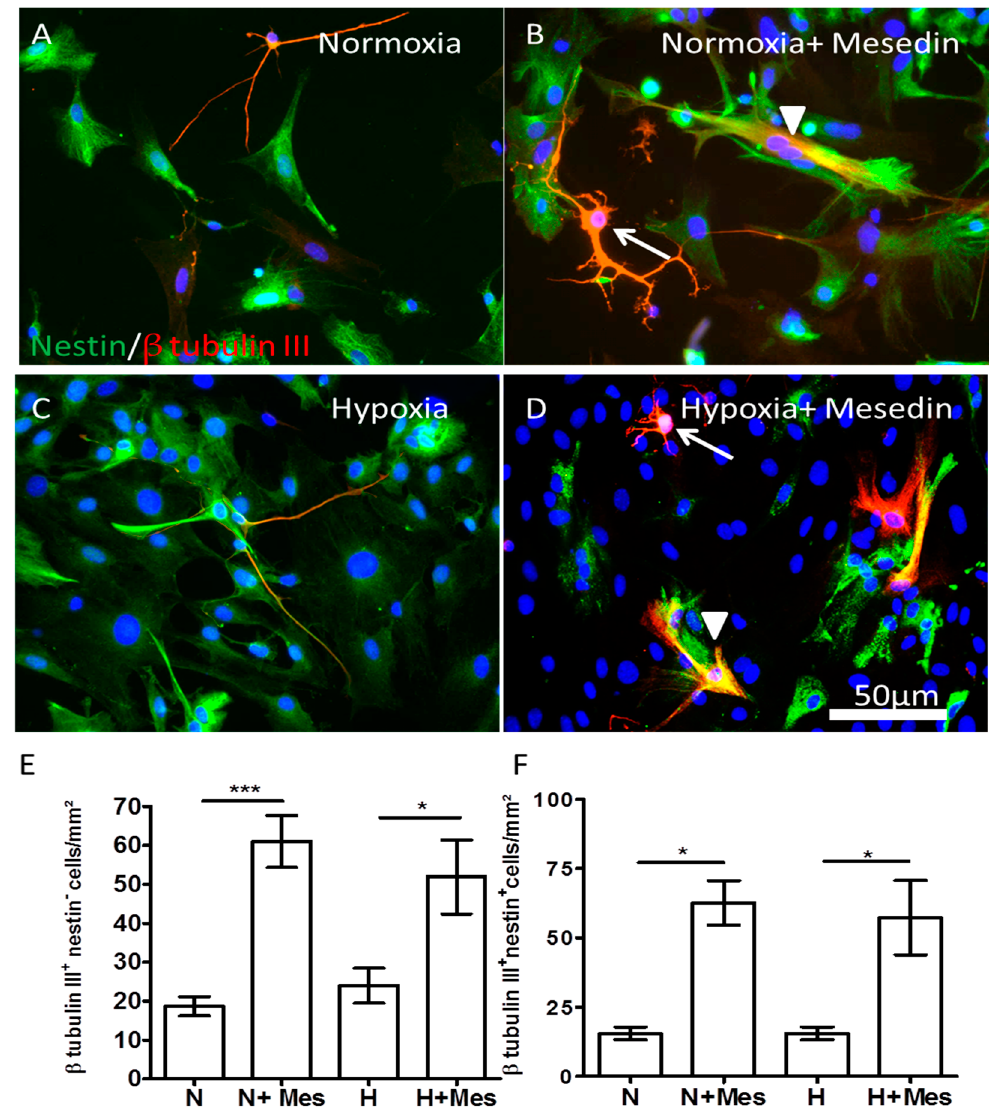
Figure 4. Mesedin enhances the survival of neurons and neuronal progenitors in APC. ( A – D ) Double staining of nestin (green) and of β -tubulin III-positive (red) neuronal progenitors, and neurons of 14 days old C57BL/6 APC under normoxic ( A , B ) and hypoxic ( C , D ) conditions. The cell nuclei are counterstained with DAPI (blue). Mesedin increases the survival and arborization of neurons (arrows in ( B , D )), and the number of nestin + / β -tubulin III + neuronal progenitors (arrowheads in ( B , D )). Scale bar 50 µm. ( E ) Quantification of β -tubulin III-positive neurons upon normoxia (N) and hypoxia (H) in mesedin treated (N + Mes and H + Mes) and control (N and H) cultures. ( F ) Quantification of nestin + / β -tubulin III + progenitors upon normoxia (N) vs. hypoxia (H) and mesedin treatment (N + Mes; H + Mes). The cells were quantified from n = 5 coverslips, and normalized to mm 2 . Data are presented as mean ± SEM, and analyzed by one-way ANOVA with Bonferroni’s comparison test. * p < 0.05; *** p < 0.001. Scale bar 50 µm.